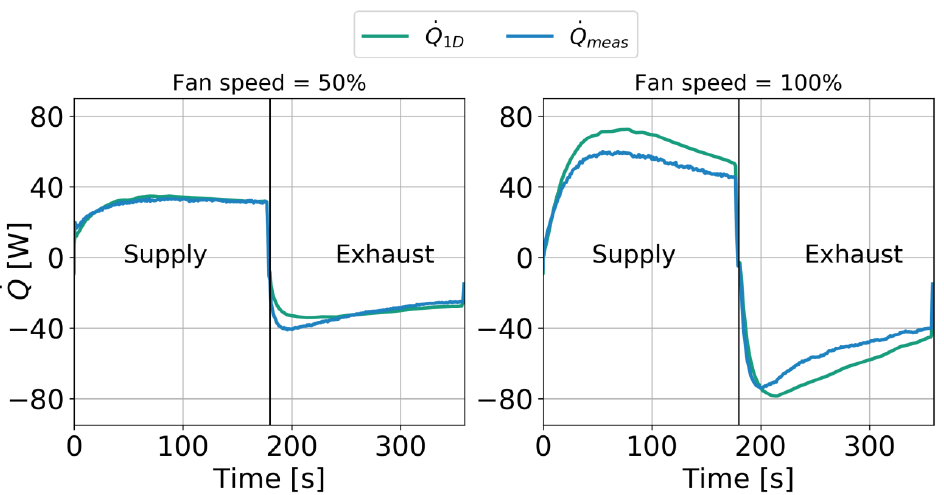
Figure 16. Supply and exhaust heat transfer rate comparison for the 180-s cycle length, measured and simulated with 1D Model.